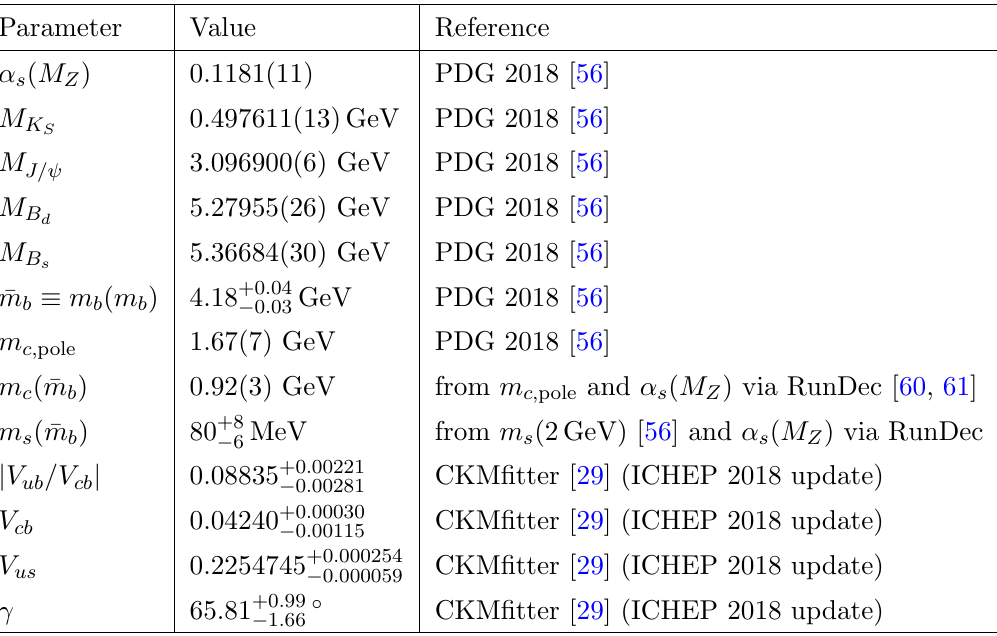
Table 2. List of input parameters needed for our theoretical